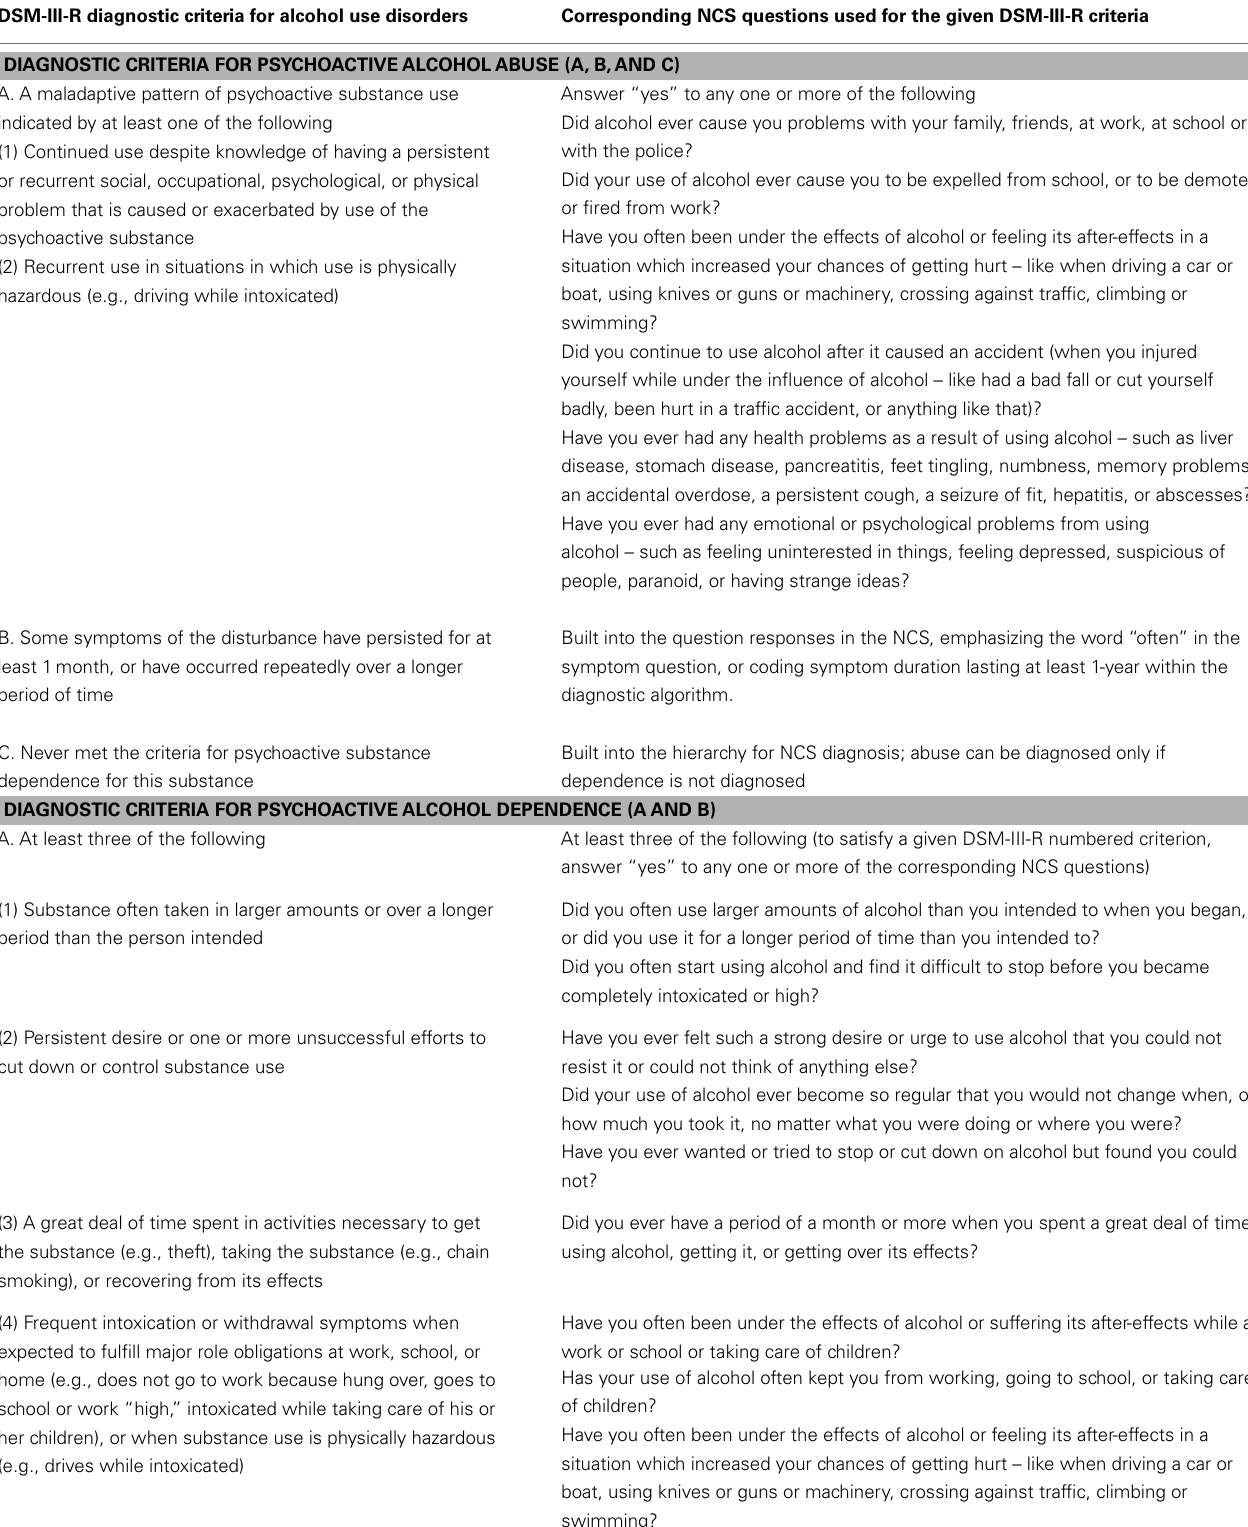
TableA2 | DSM-III-R diagnostic criteria for alcohol use disorders and their translation using National Comorbidity Survey (NCS) questions . DSM-III-R diagnostic criteria for alcohol use disorders Corresponding NCS questions used for the given DSM-III-R criteria DIAGNOSTIC CRITERIA FOR PSYCHOACTIVEALCOHOLABUSE (A, B,AND